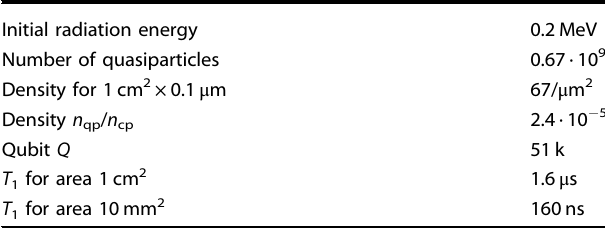
Table 4. Quasiparticle down-conversion and qubit decay.